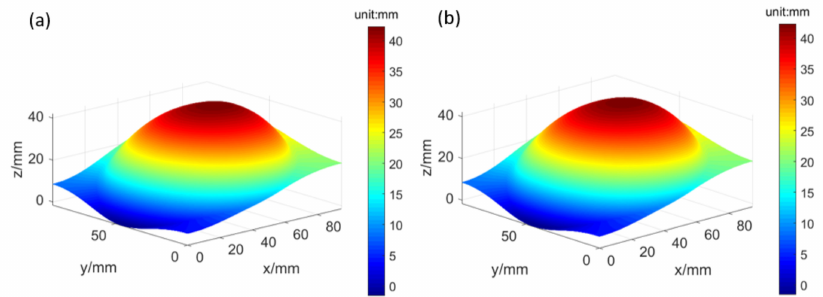
Figure 7. The height maps of the ball contour obtained using ( a ) the proposed 2D digital shearography with source displacement and ( b ) the traditional 1D digital shearography with source displacement.